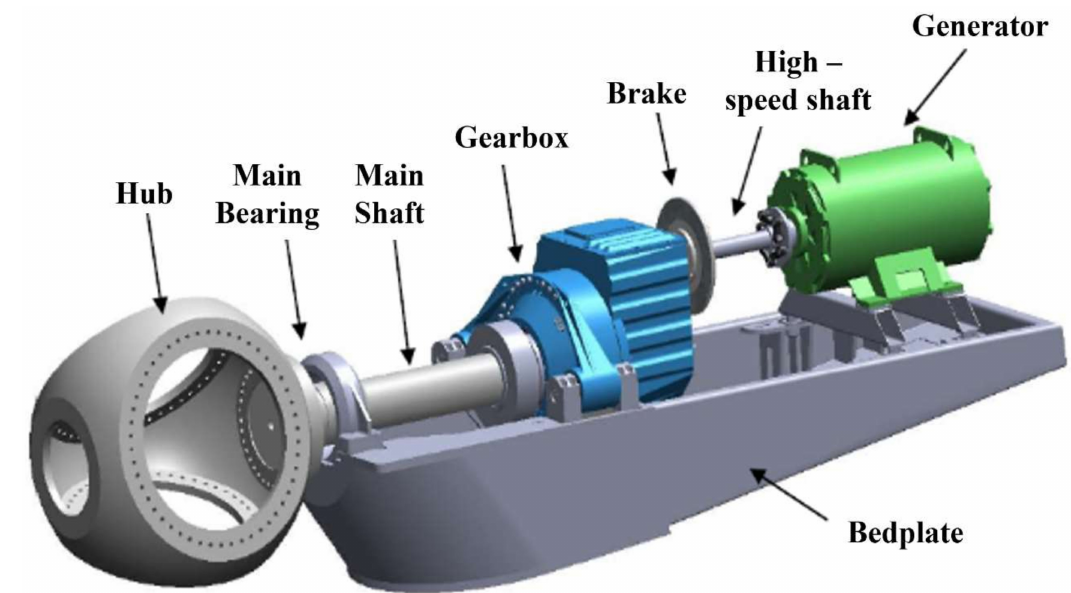
Figure 14. Wind turbine drive-train mechanism [99].